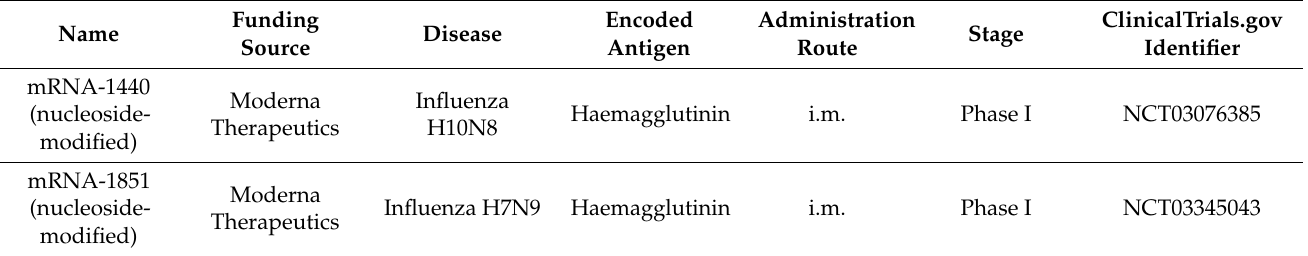
Table 3. Clinical trials of lipid nanoparticle–mRNA vaccines for lung viral infectious